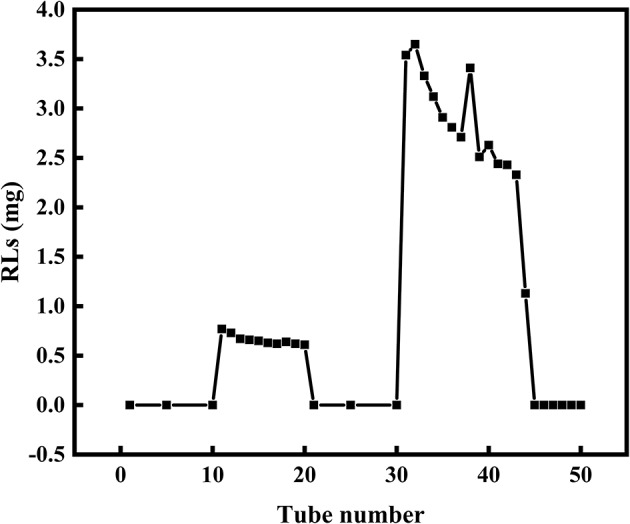
The separation of mono- and di-RLs by silica gel column chromatography. Mono- and di-RLs were separated by gradient solvent elution. Tubes 0–10 were eluted with solvent II. Tubes 11–20 were eluted with solvent III to release mono-RLs. Tubes 21–30 tube were eluted with solvent IV, which confirmed that mono-RLs were entirely eluted because nothing was eluted in this fraction. Tubes 31–40 were eluted with solvent V to release di-RLs from the column.